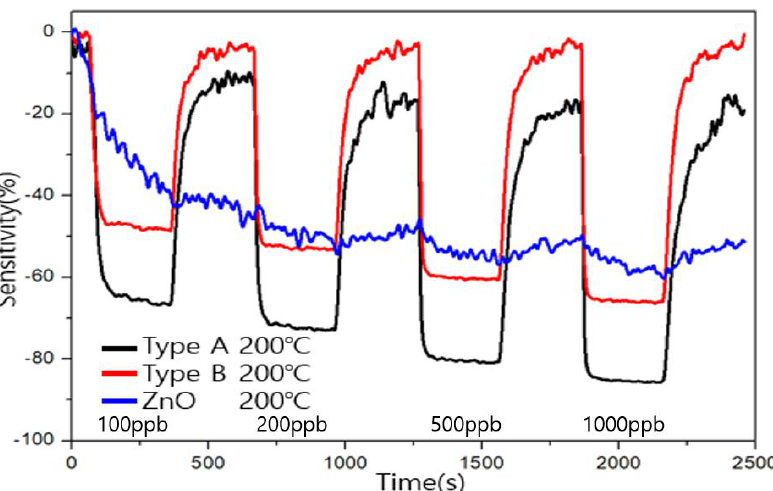
Figure 11. Comparison of sensitivity and recovery to formaldehyde at 200 °C between low-dimensional allotrope modified ZnO sensor (type A and type B) and ZnO sensor.